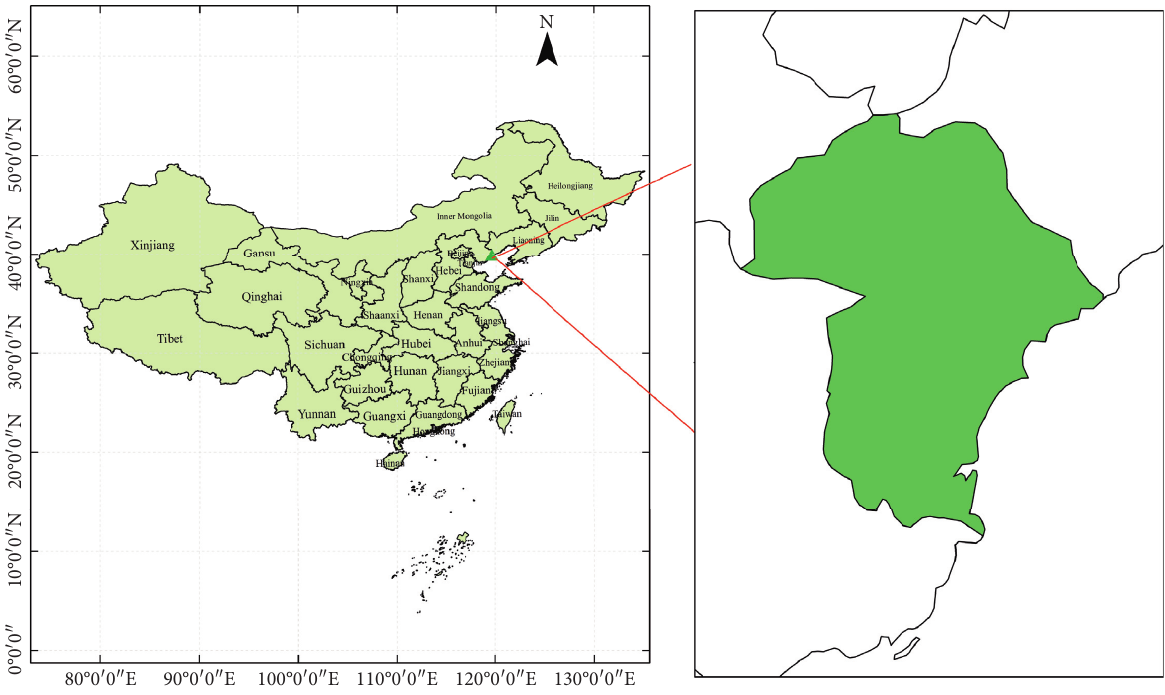
Figure 1: Locations of the Qinhuangdao city.